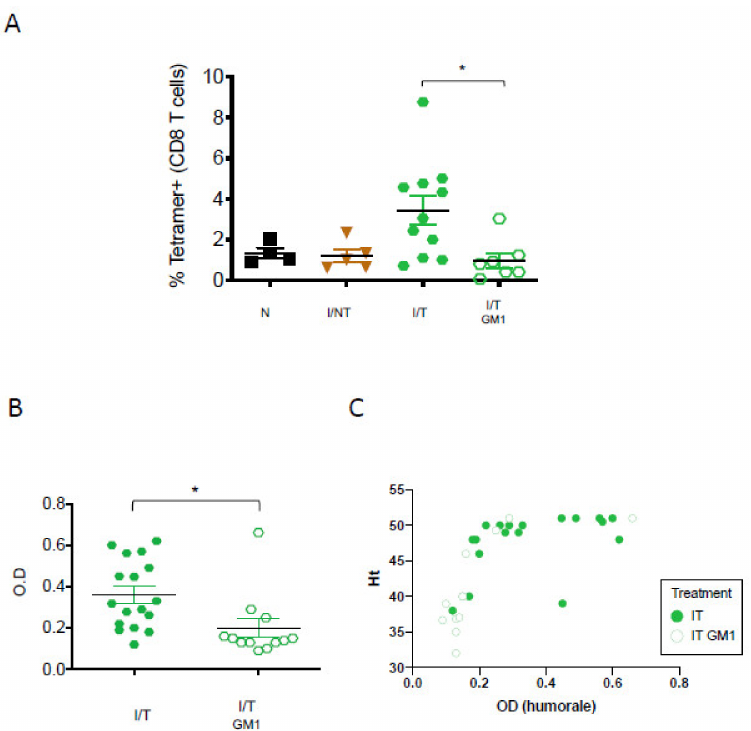
Figure 3. Assay of FrCasE-specific CD8 + T cells and humoral responses in infected/treated mice in the presence and in the absence of NK cells. NK cells were depleted in infected/treated mice as indicated in Figure 2A: ( A ) frequency of FrCasE-specific CD8 + T cells. Spleen cells were isolated at day 14 p.i. and the frequency of virus-specific CD8 + T cells in the total CD8 + T-cell population was assayed by flow cytometry using the H2D b -GagL MHC tetramer. The data correspond to 2 independent experi- ments with the following number of mice per group: naïve (N) ( n = 4); infected/non-treated (I/T) ( n = 5); infected/treated (I/IT) ( n = 11), infected/treated-GM1 (I/IT GM1) ( n = 7); ( B ) Seric FrCasE- specific IgG concentration was assayed by ELISA at 67 days p.i. The data represent 2 independent experiments with the following number of mice per group: infected/treated ( n = 17), infected/treated- GM1 ( n = 12). (* p < 0.05); ( C ) assessment of serum anti-FrCasE IgG levels in infected/treated